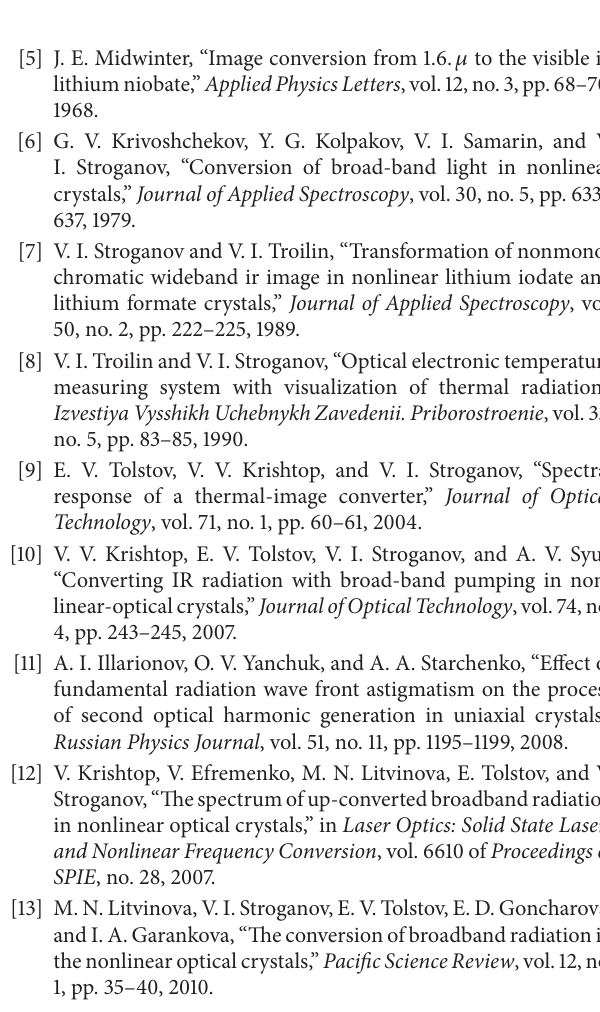
Figure 3: Dependence of integrated power of converted broadband radiation on (a) convergence angle of an input beams and (b) temperature of thermal object. The solid line—theoretical results, the dashed line and dots—experimental